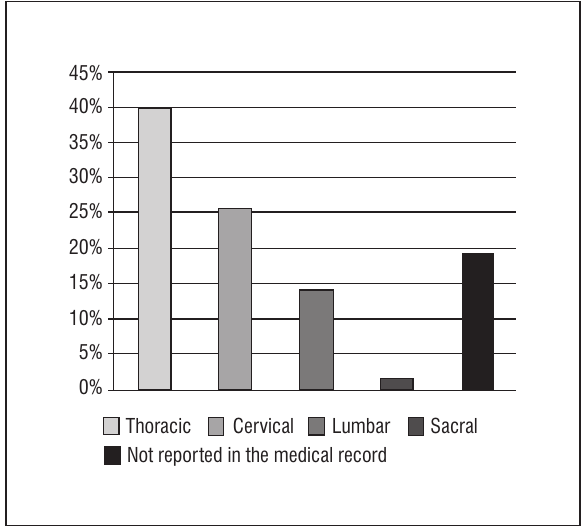
Figure 3 - Regions of the spine most frequently affected by spinal cord trauma